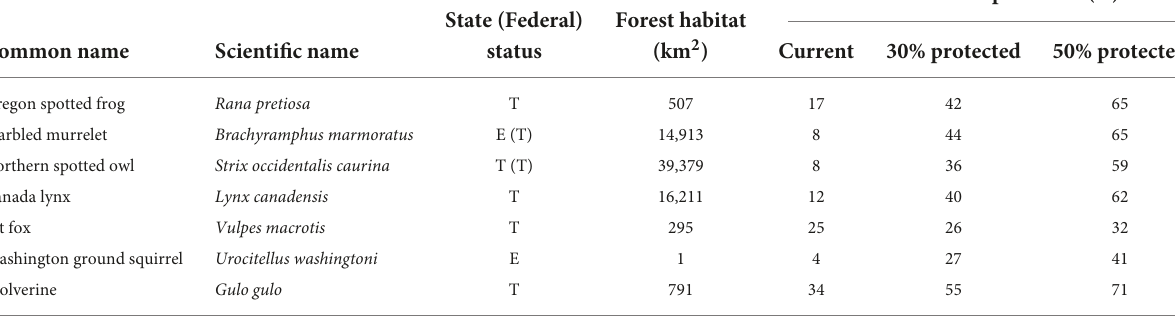
TABLE 4 Current and potential habitat protection for animal species listed as threatened (T) or endangered (E) by the state of Oregon.